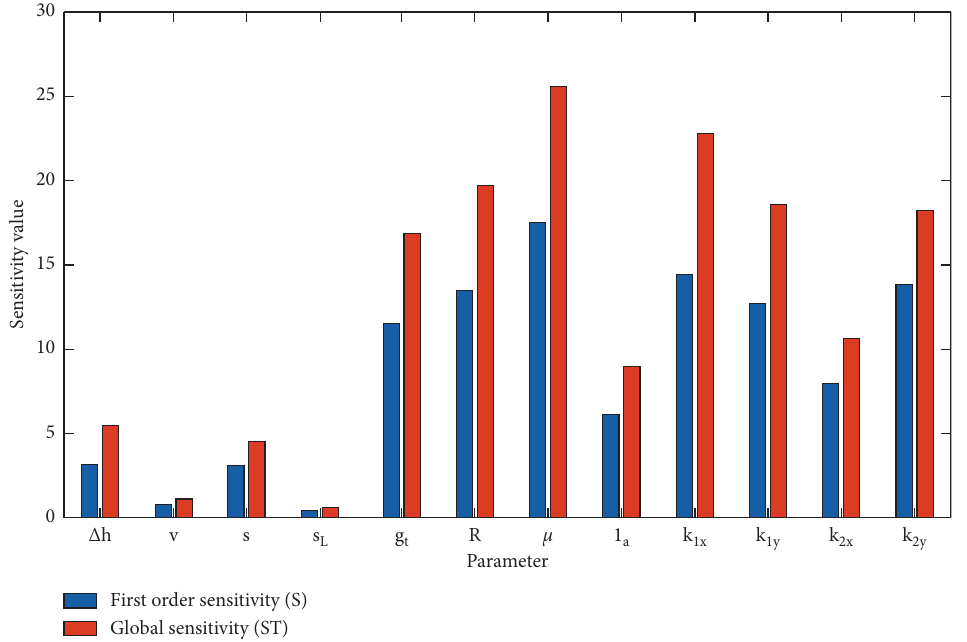
Figure 4: Global sensitivity analysis